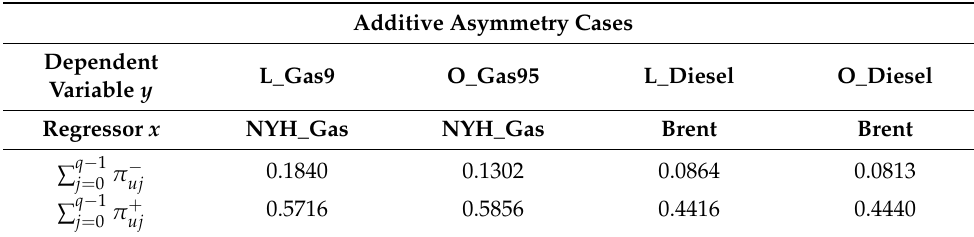
Table 7. Aggregates of significant positive and negative short-run multipliers of USD/PLN exchange rate. Additive Asymmetry